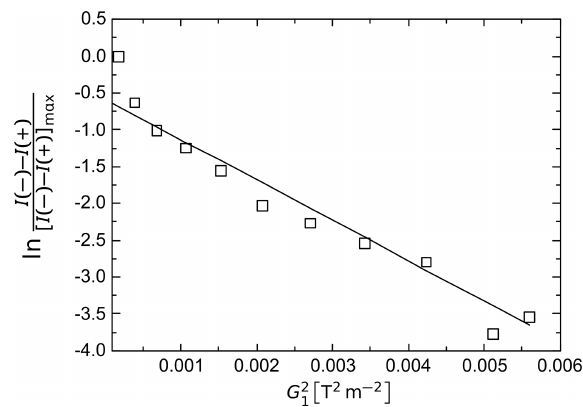
dependence of the normalized difference spectra in- Figure 5. G 2 1 tegrals of the z profiles in SNGE I ( − ) and I ( + ) diffusion exper- iments from the three-gradient pulse scheme (Fig. 3) applied to 90%:10% H 2 O:D 2 O at T = 295K. The solid line is added to guide the eye and to emphasize the approximately linear part of the attenuation curve. ( G 2 = G 1 , G 3 = 1 . 6 mT , δ 1 = 2, (cid:49) = 0 . 1, m δ 2 = 1ms, a gradient stabilization delay (cid:15) = 0 . 05ms, and an acqui- sition time t aq = 3 .